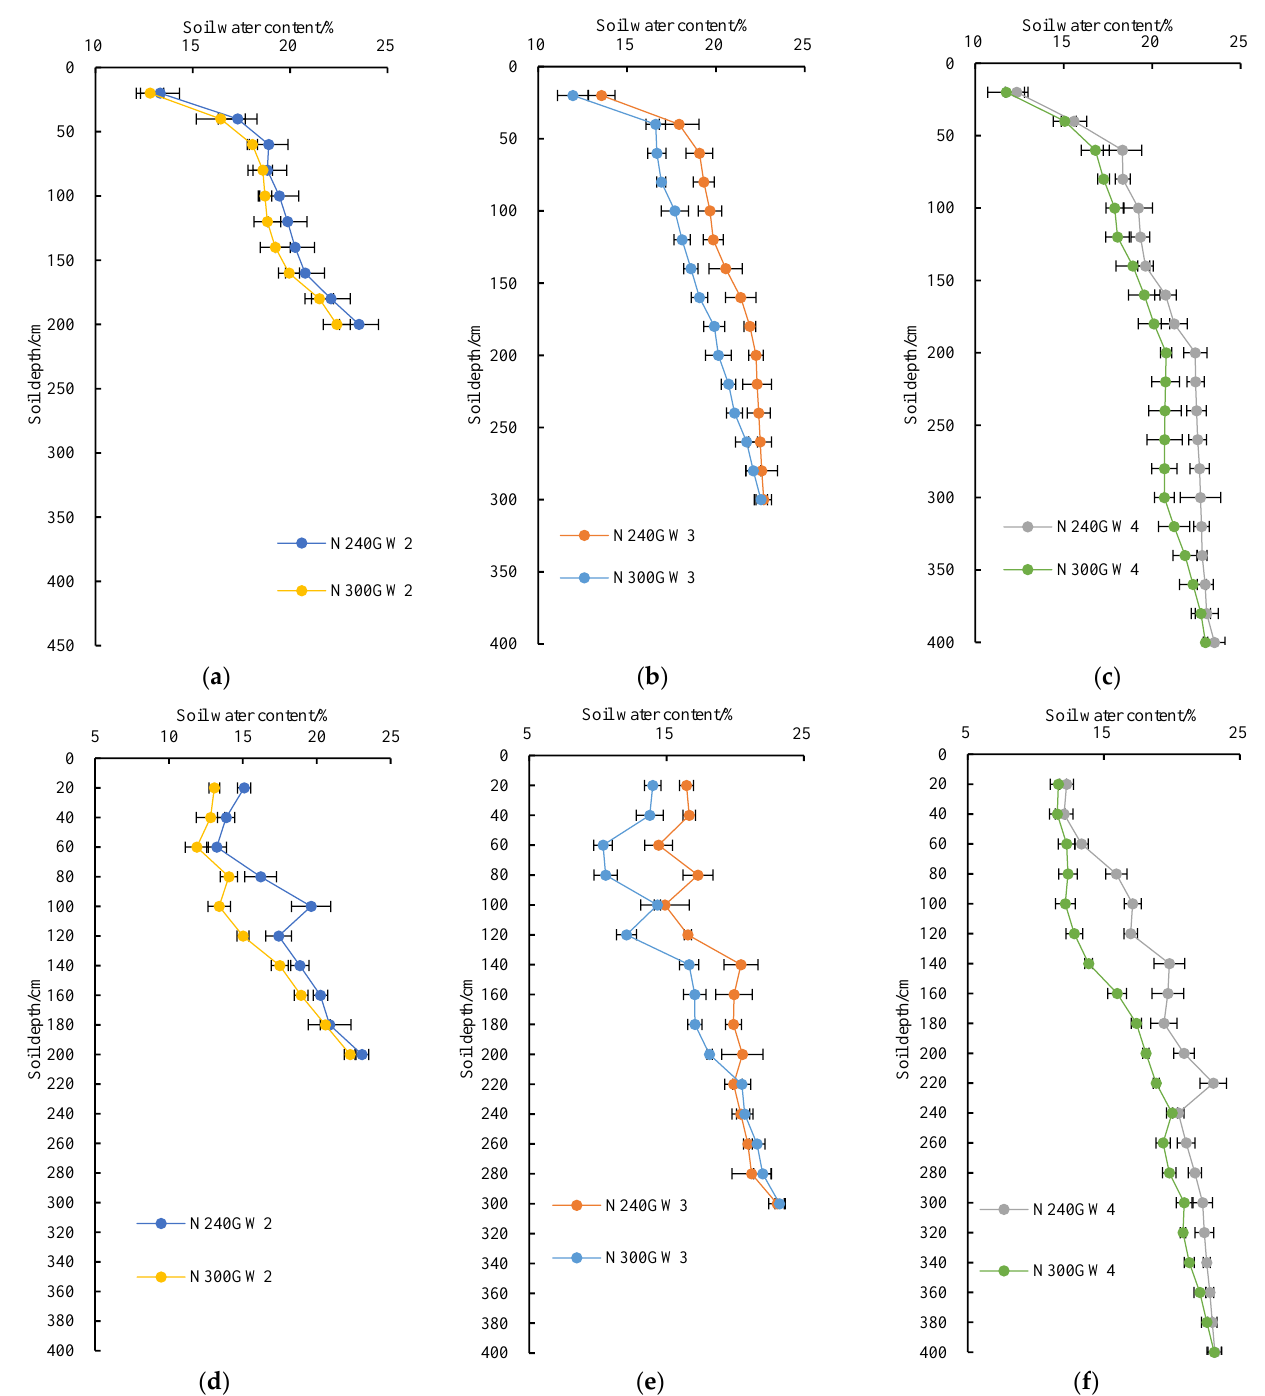
Figure 4. Soil water content of different soil depths at the maturity stage of summer maize and winter wheat. ( a ) GW2 in summer maize; ( b ) GW3 in summer maize; ( c ) GW4 in summer maize; ( d ) GW2 in winter wheat; ( e ) GW3 in winter wheat; ( f ) GW4 in winter wheat.